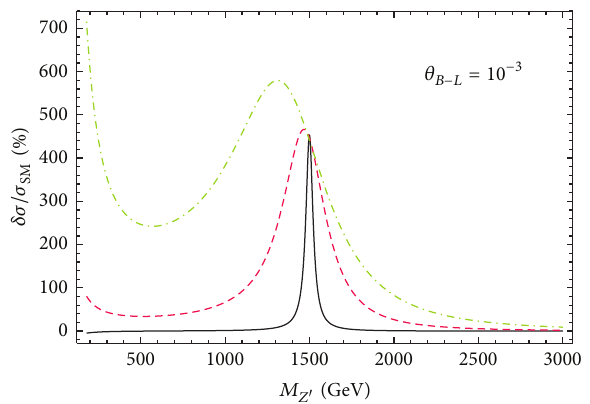
Figure 8: The total cross sections of the production processes 𝑒 + 𝑒 − → 𝑍ℎ as a function of the collision energy. The curves are for SM (solid line) and 𝑀 𝑍 󸀠 = 1500 , 2000 , 2500 GeV (dashed line, dot-dashed line, and dotted line). The resonance corresponds to the 𝑍 󸀠 new gauge boson.